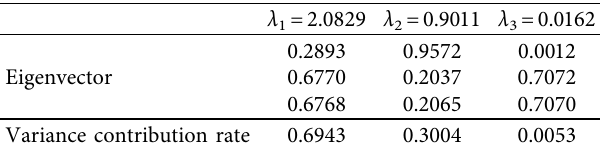
Table 3: Principal component scores of training samples. Table 2: Feature vectors corresponding to the three characteristic